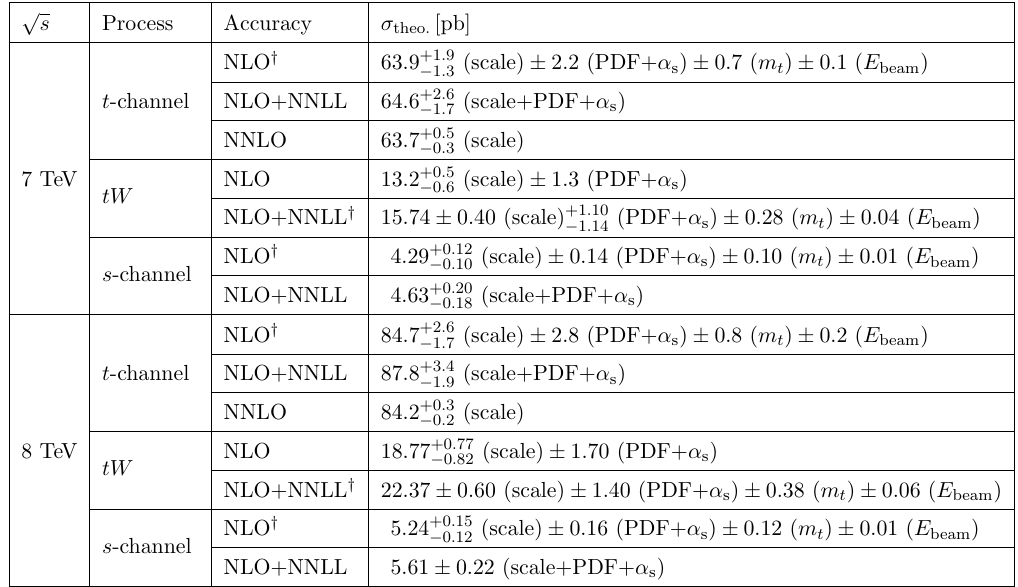
Table 1 . Predicted cross-sections for single-top-quark production at p s = 7 and 8 TeV at the LHC. Uncertainties include scale and PDF+ (cid:11) s variations, except for the NNLO predictions, which only contain the scale variation. The PDF+ (cid:11) s uncertainties are evaluated according to the PDF4LHC prescription only for the NLO predictions. The uncertainties associated with the top-quark mass m t and beam energy E beam are also given for the NLO predictions for the t - and s -channels, and for the NLO+NNLL prediction for tW production. The value of m t is set to 172 : 5 GeV in all predictions. The cross-sections marked with y are those used in the